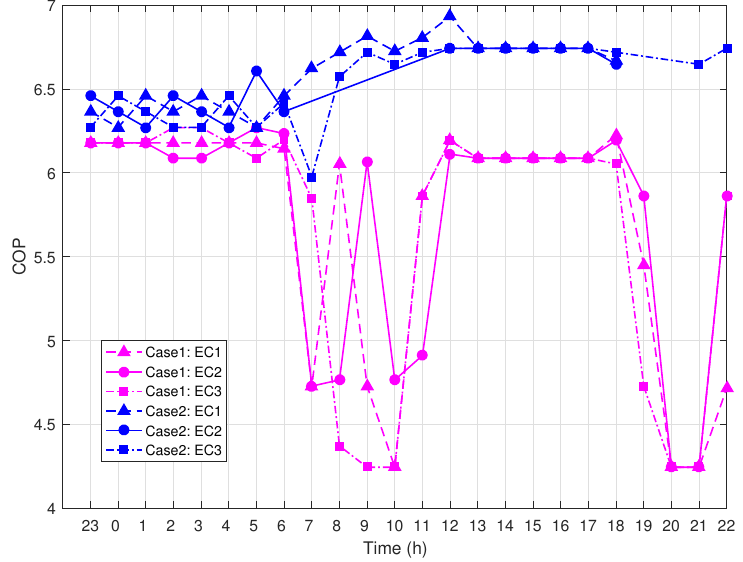
Figure 12. The curves of COPs of all ECs in different cases.